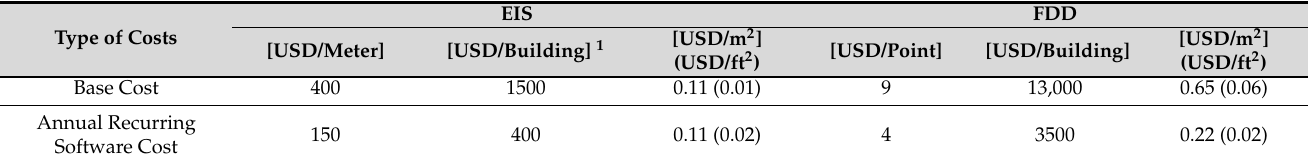
Table 4. Median base technology costs and median annual recurring technology costs for EIS and FDD tools. EIS FDD Type of